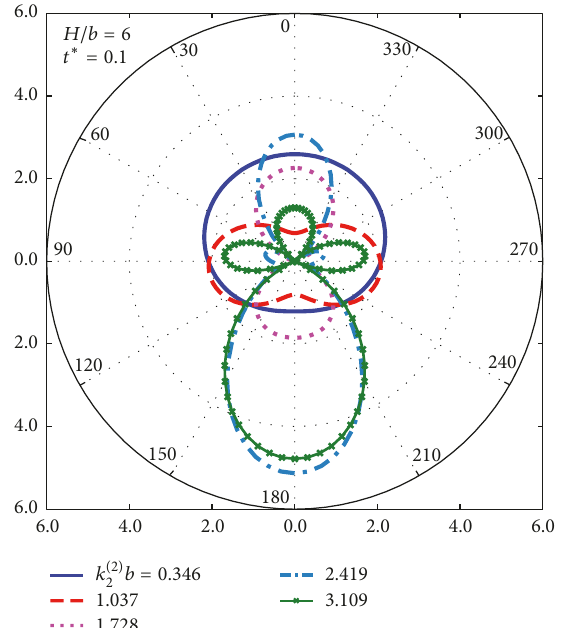
Figure 10: Tangential stress (𝜎 ∗ 𝜃𝜃 ) versus polar angle at 𝑟 = 𝑏 for different wave numbers (𝑘 (2) 2 𝑏) for a tunnel in soft